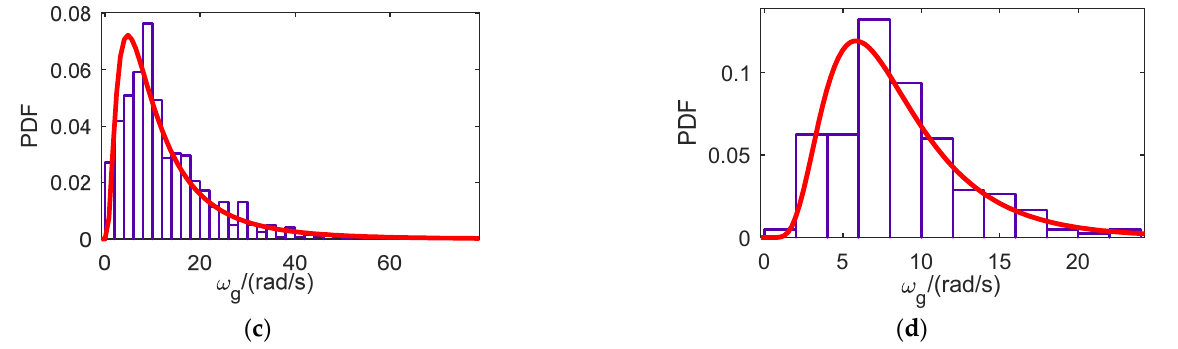
Figure 4. Histogram and the probability density function of ω g in four kinds of sites: ( a ) Site I ( b ) Site Ⅱ ( c ) Site Ⅲ ( d ) Site Ⅳ [5].